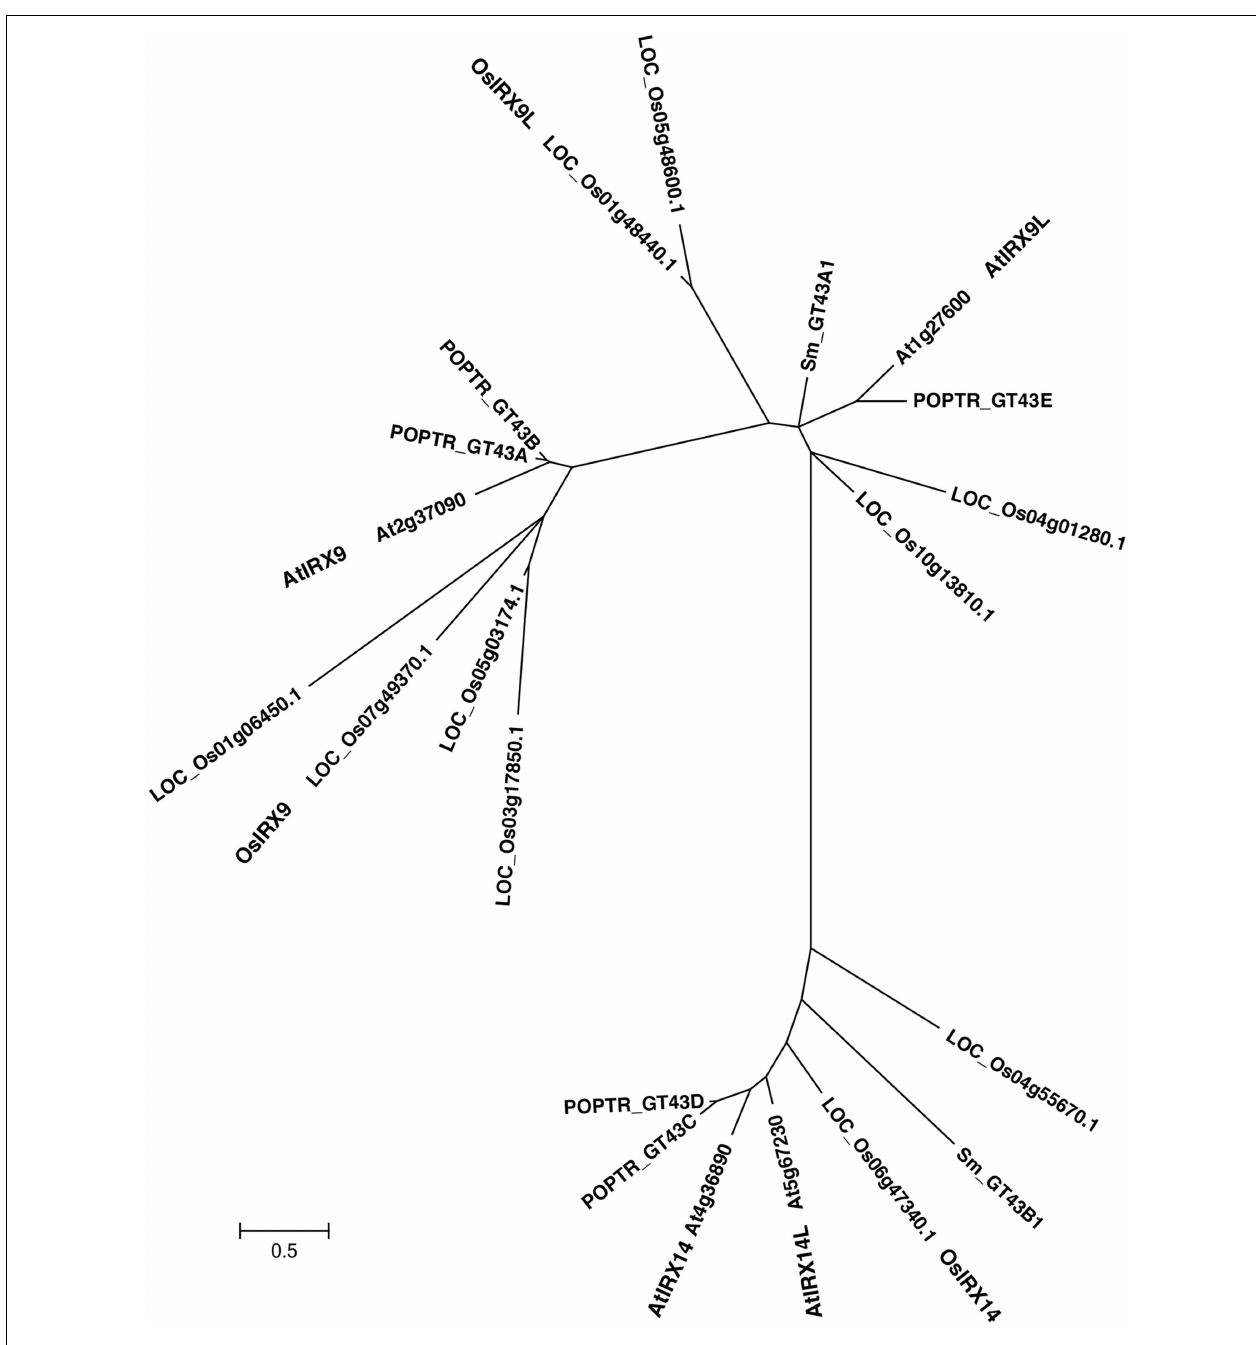
evolutionary distances used to infer the phylogenetic tree.The evolutionary distances were computed using the JTT matrix-based method and are in the units of the number of amino acid substitutions per site.The rate variation among sites was modeled with a gamma distribution (shape parameter = 1). Evolutionary analyses were conducted in